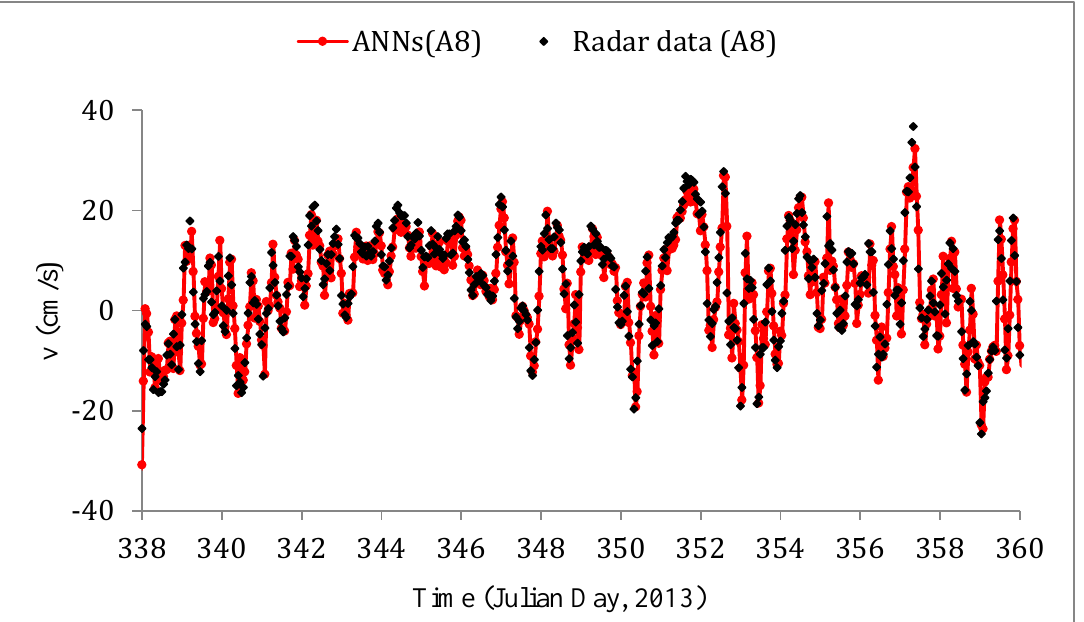
Figure 9. Forecasts of v velocity component at A8 (Model V9, 1 h forecast window).